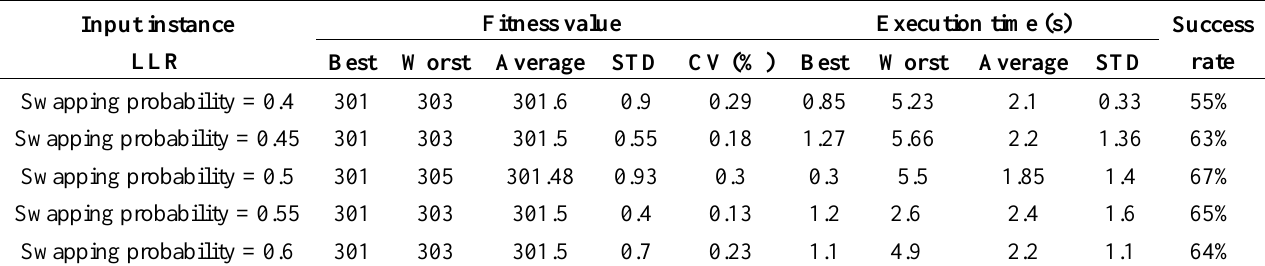
Table 16. Investigating the effect of swapping probability for input instance, LLR.